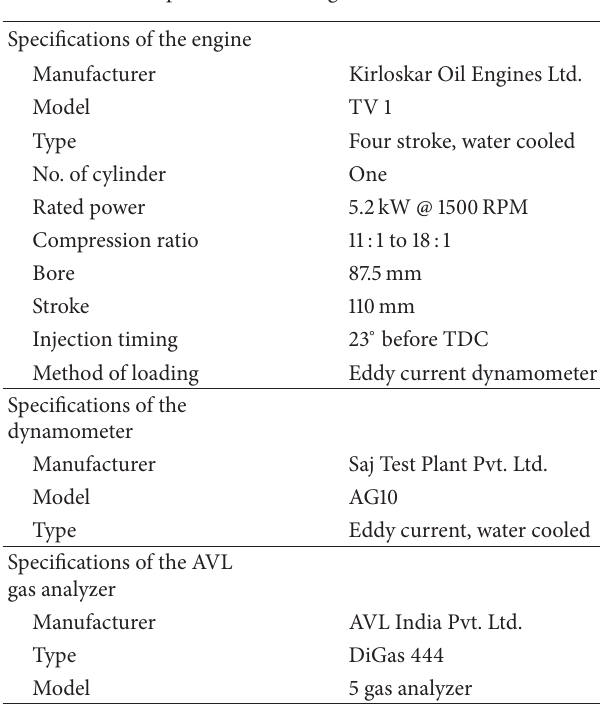
Table 3: Specifications of engines and